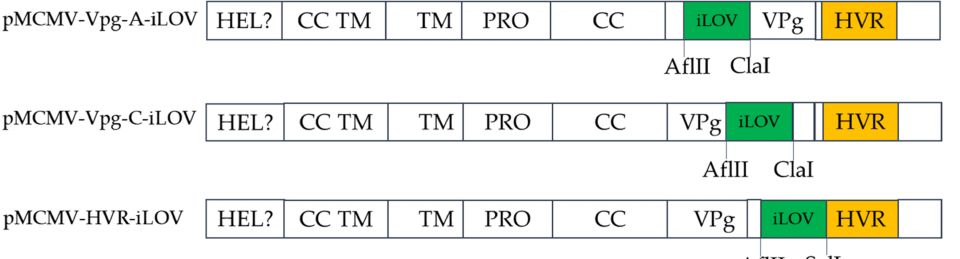
Figure 5. Schematic diagram showing the site of insertion of iLOV.